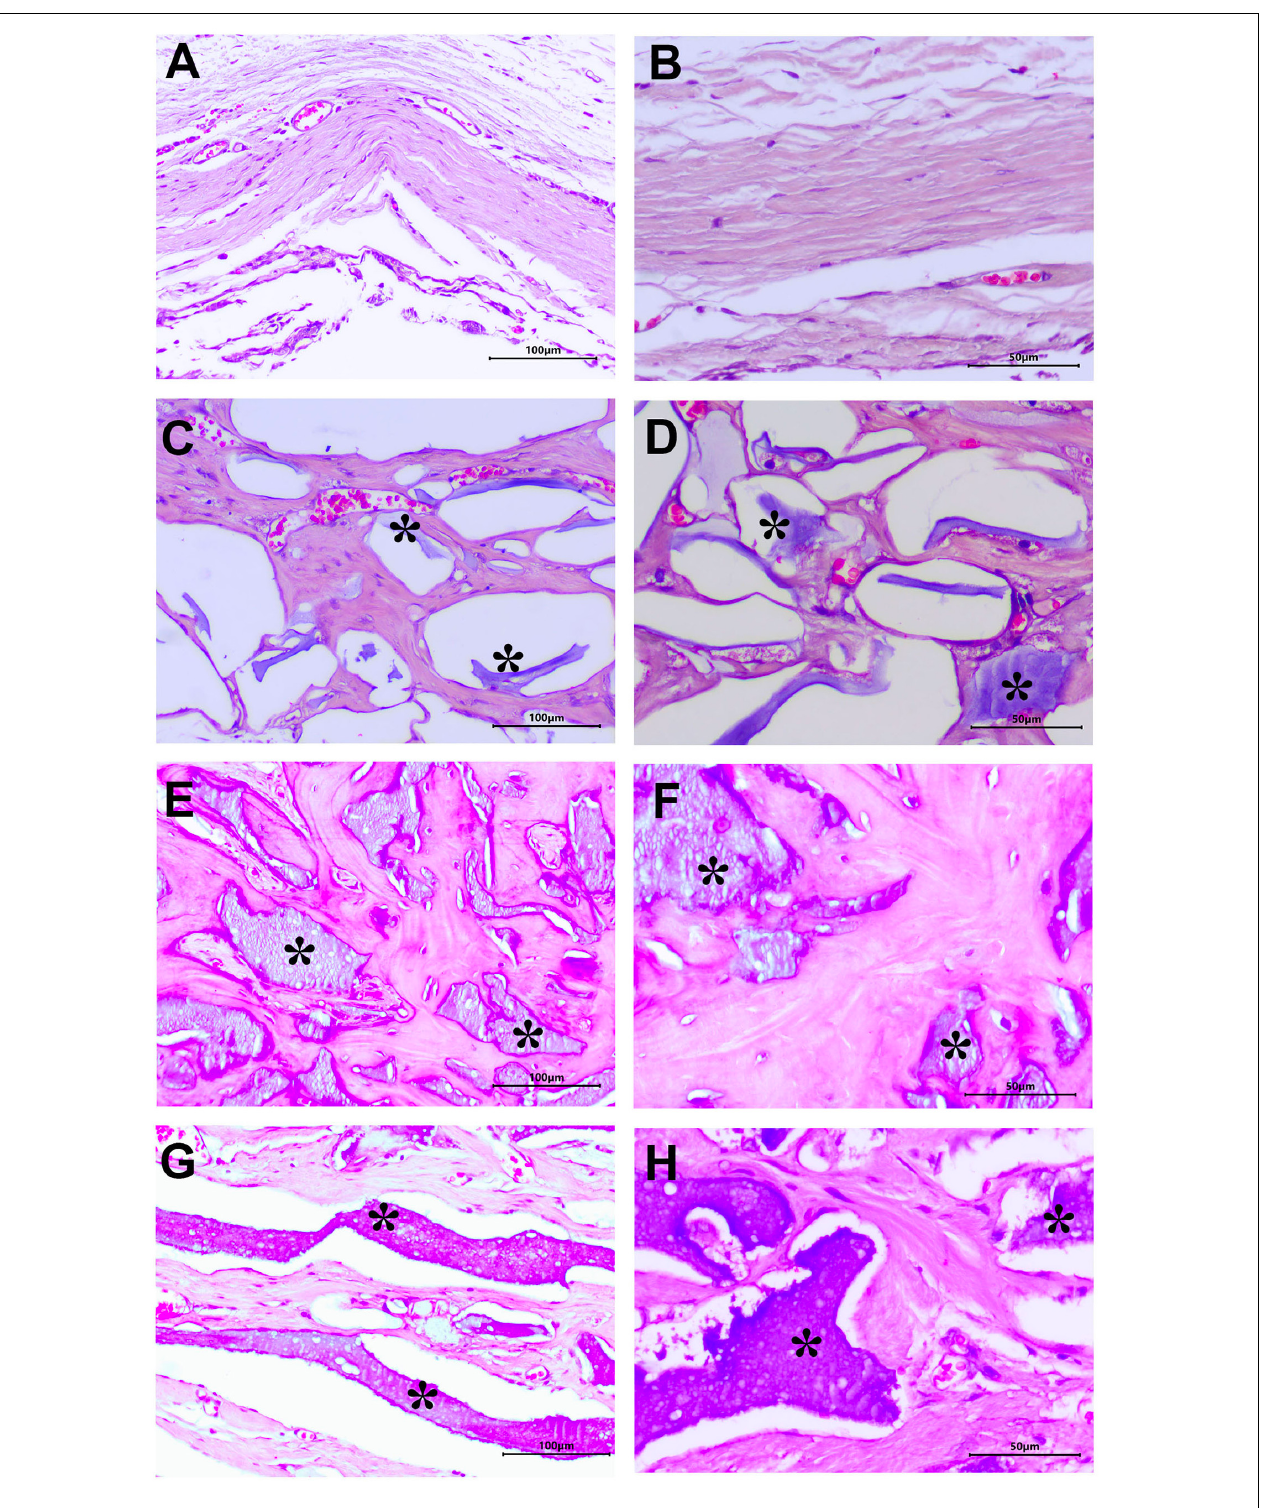
FIGURE 4 | Photomicrographs of histological sections stained with H&E. The images are representative of the different groups at 90 days. (A,B) No treatment (NT). (C,D) MAS0. (E,F) MAS30. (G,H) MAS50. All images are shown at 20 × and 40 × , respectively. The asterisks correspond to the MAS scaffolds.